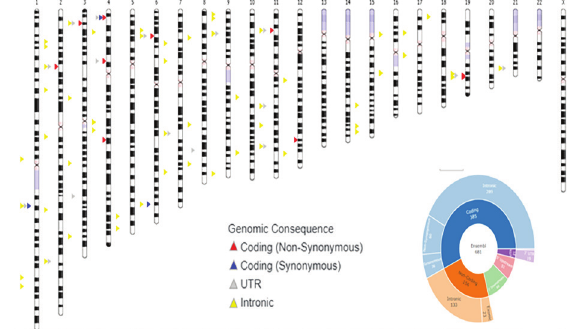
Figure 1 - Graphical representation of the panel of genetic polymorphisms (n =